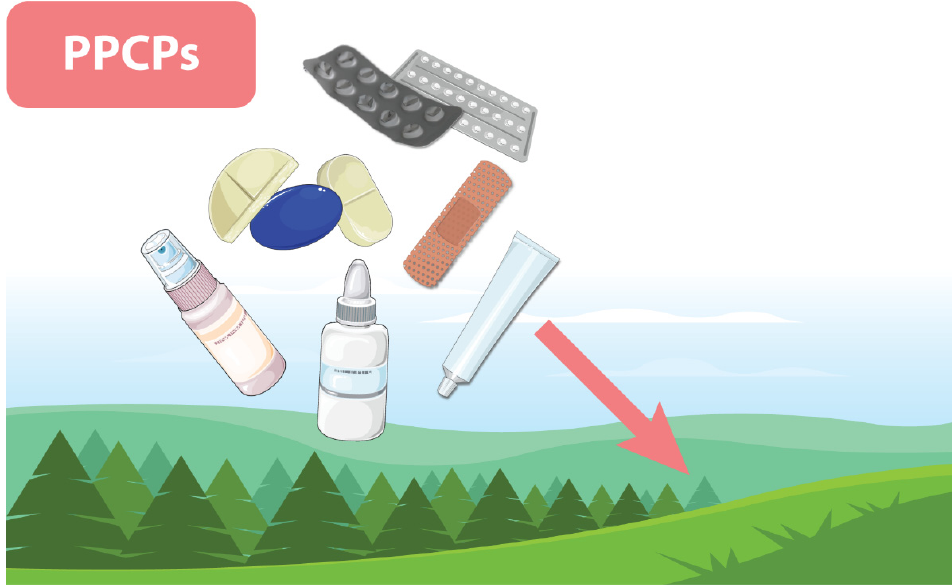
Figure 1. Pharmaceuticals and personal care products in the environment; PPCPs—pharmaceuticals and personal care